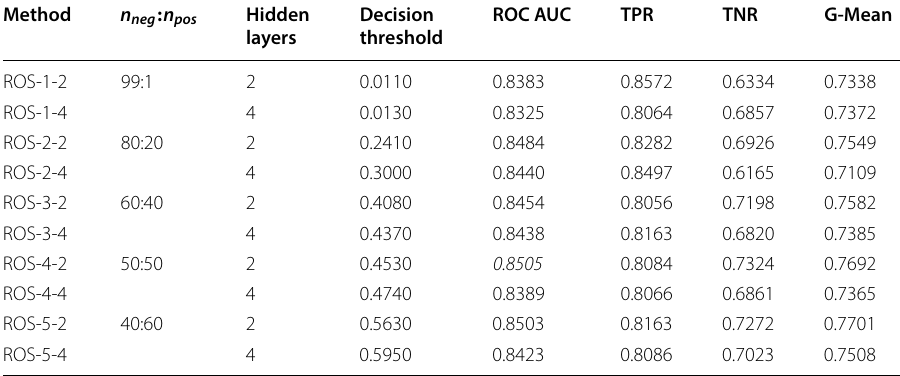
Table 14 Average ROS results (30 runs)